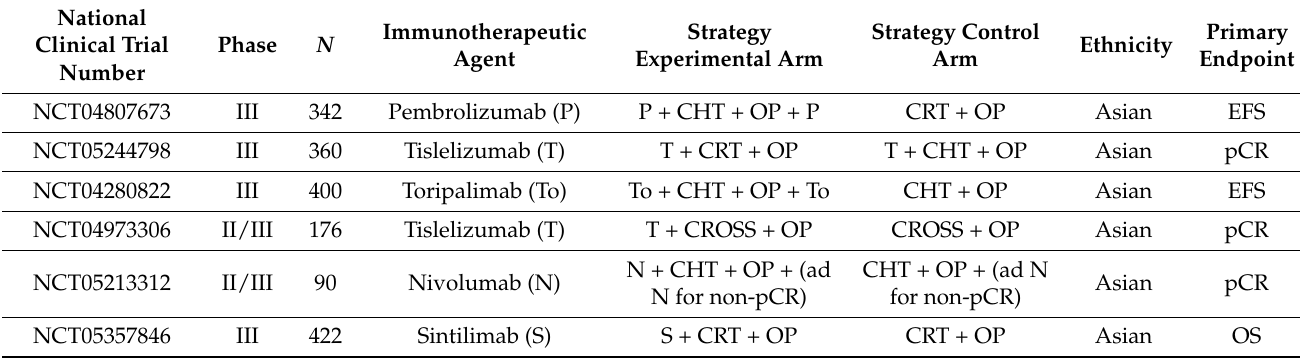
Table 3. Immunotherapy trials for patients with localized esophageal squamous cell carcinoma in perioperative